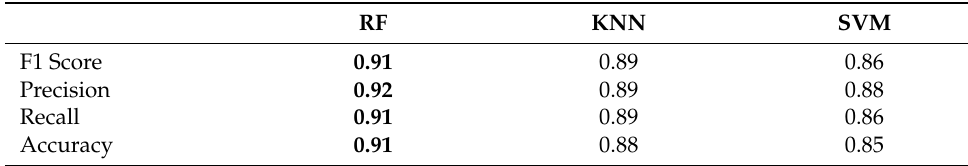
Table 3. Detection Model Results (Balanced Data